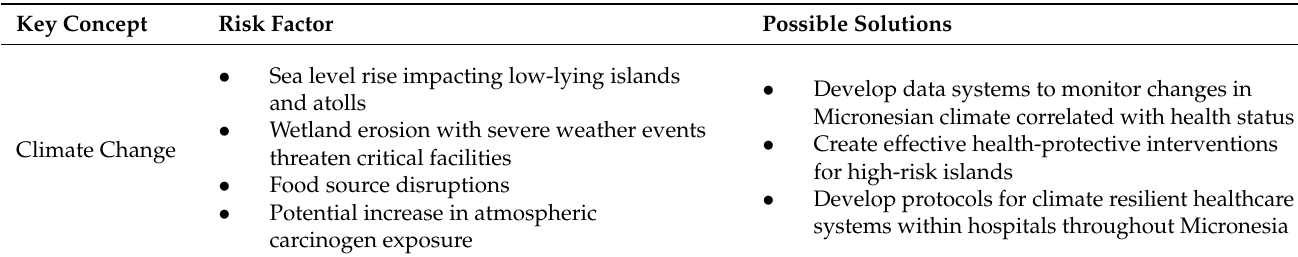
Table 7. Risk factors and possible solutions for healthcare access, health insurance, and perceptions of cancer care related to Micronesians with respect to